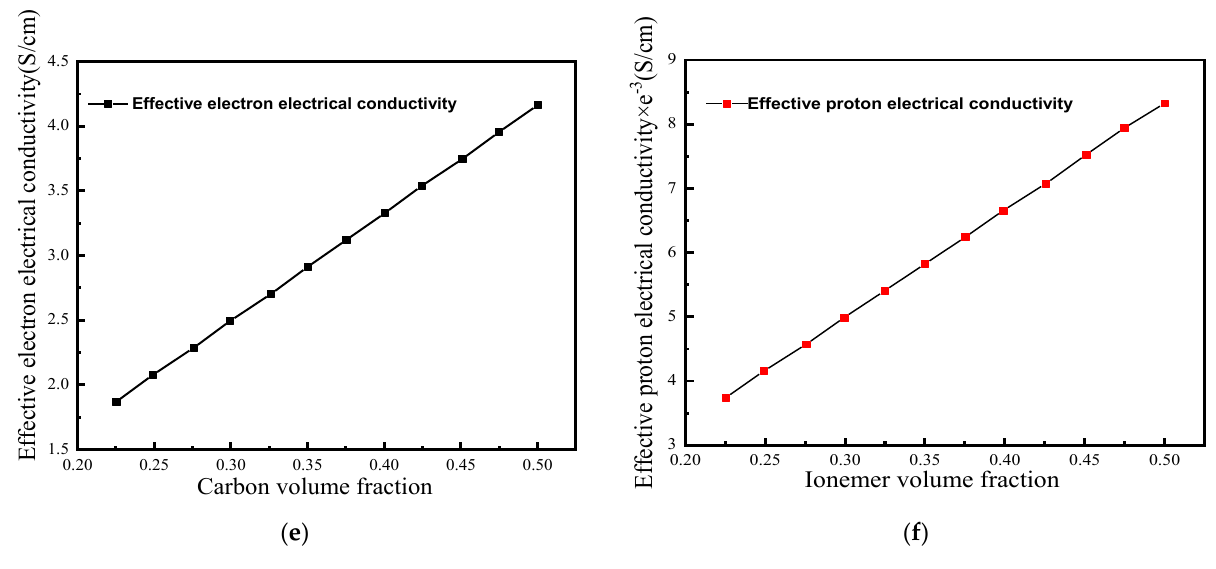
Figure 3. The relationship between various variables and porosity: ( a ) relative diffusion coefficient, ( b ) effective oxygen diffusivity, ( c ) effective water vapor diffusivity, ( d ) effective nitrogen diffusivity, ( e ) the relationship between the effective electron conductivity and carbon volume fraction, and ( f ) the relationship between the effective proton conductivity and ionomer volume fraction.